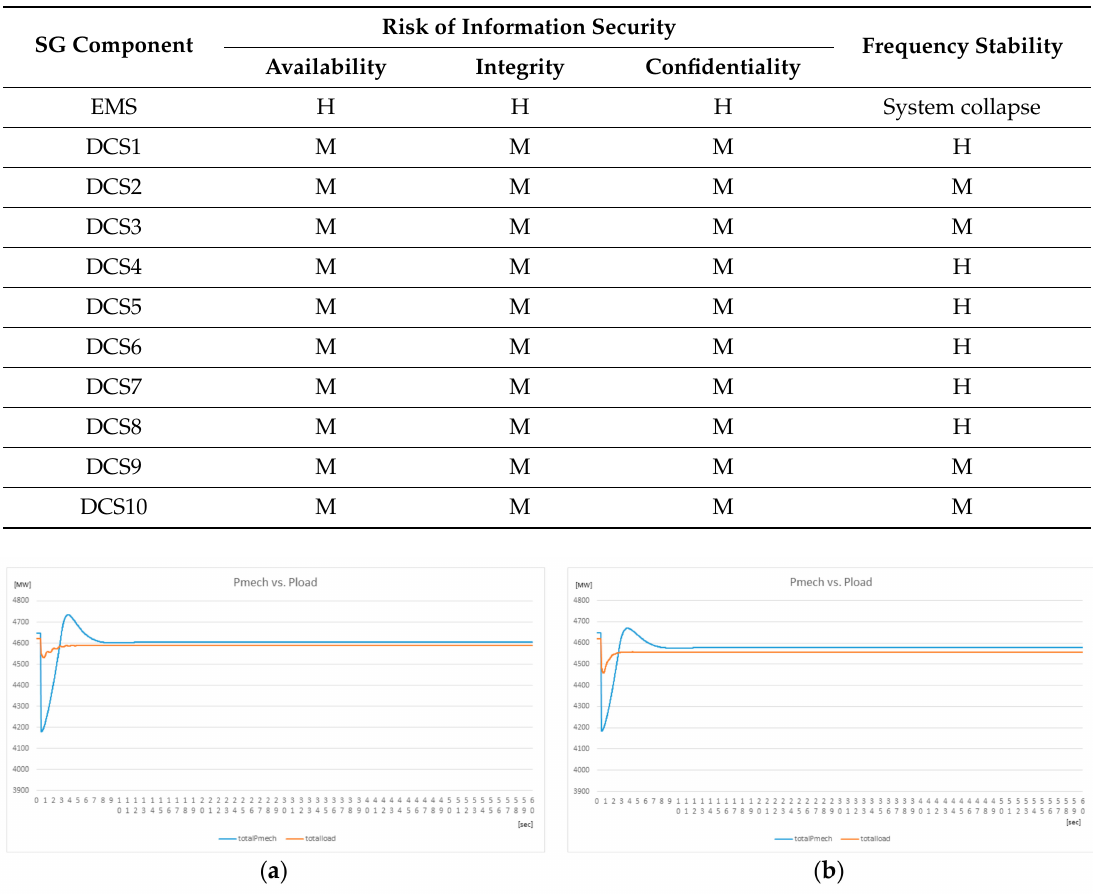
Table 7. Result on evaluating risk impact.